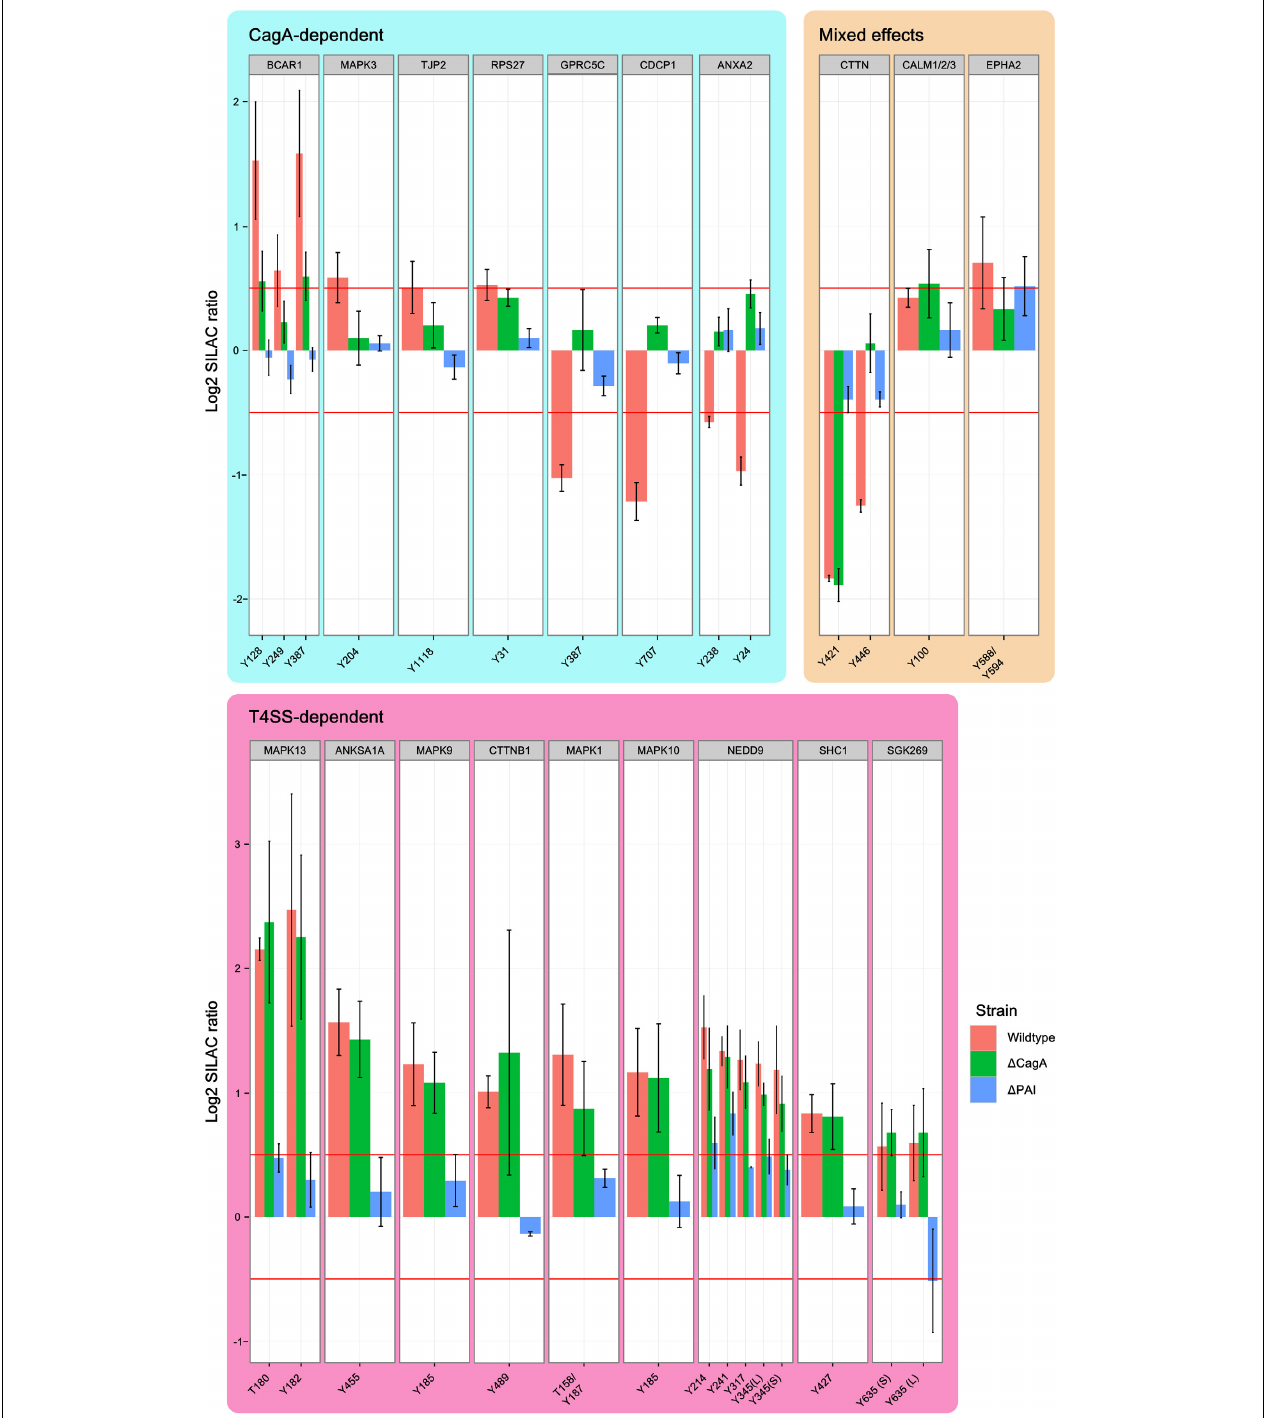
FIGURE 4 | Effect of the Cag PAI on protein phosphorylation. Phosphosites regulated by T4SS components 90min after infection with H. pylori . Shown are all phosphopeptides which are regulated in at least one condition, grouped according to whether regulation is dependent on CagA or T4SS. Identical phosphosites that were identified in different peptides are differentiated as longer (L) or